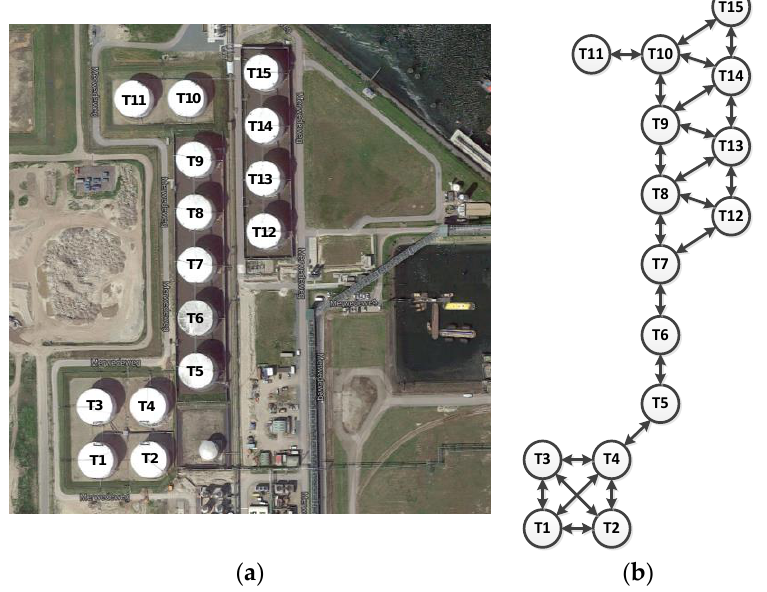
Figure 10. ( a ) An oil terminal. ( b ) Possible fire spread scenarios as a directed graph.